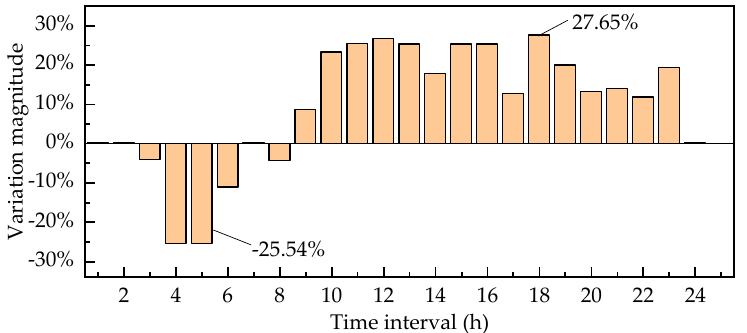
Figure 10. Variation magnitude of marginal price of the day-ahead electricity market.